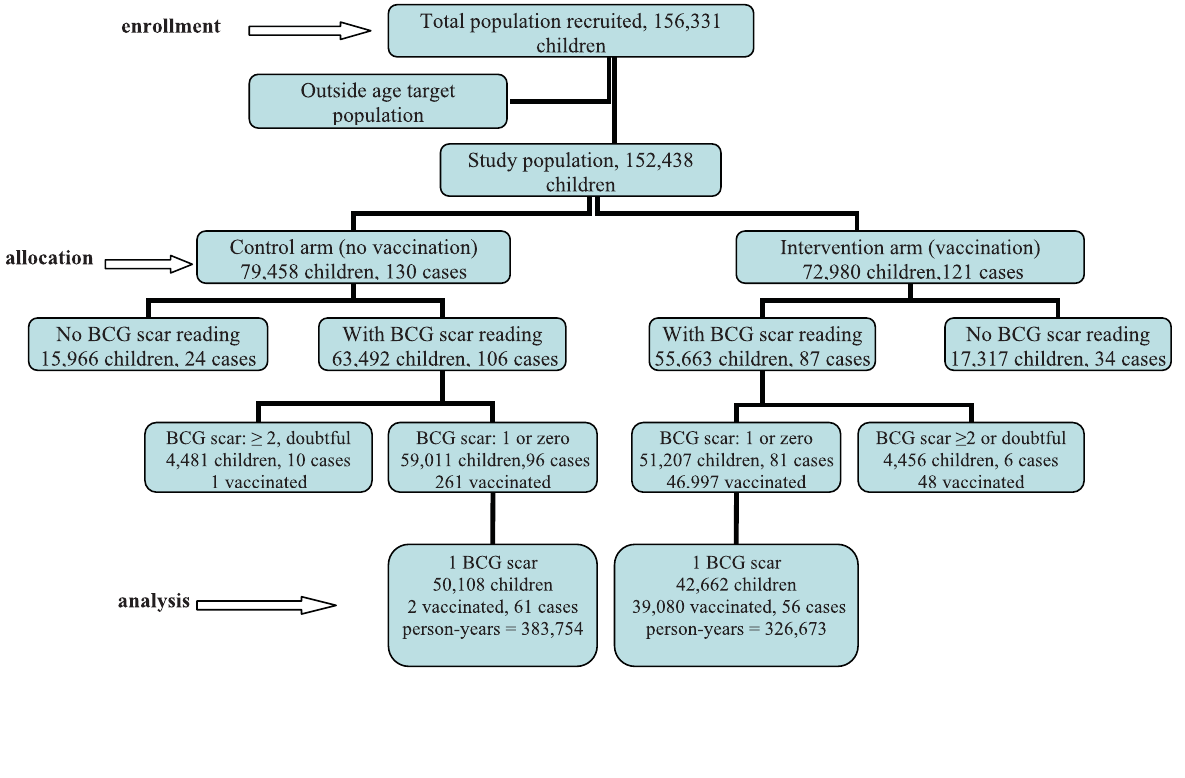
Figure 1. Flow of clusters and individual participants through each stage.